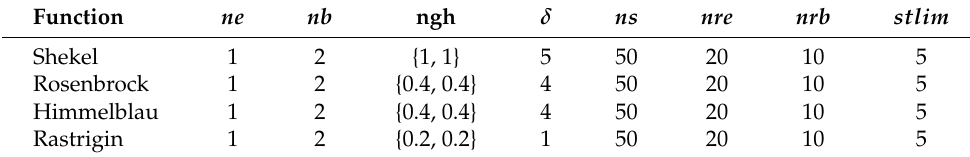
Table 6. SBA parameters.